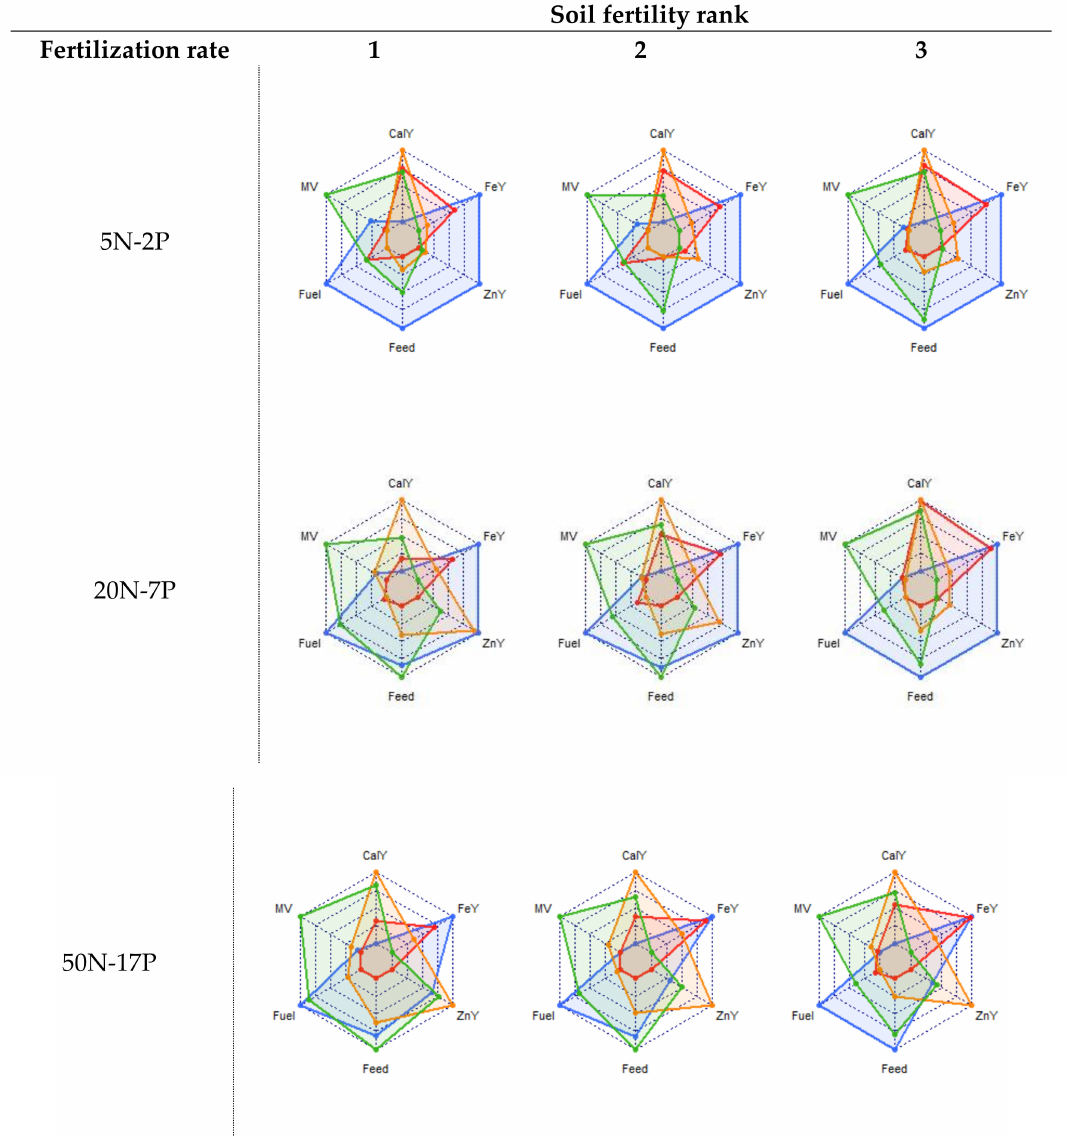
Figure 6. Multi-criteria yield assessments on an area-scaled basis (per hectare) of millet (blue), sorghum (red), maize (yellow) and rice (green); in six different paddocks, defined by two factors: mineral fertilizer application rate (kg ha − 1 of nitrogen and phosphorus) and soil fertility characteristics (1 = upland low fertility, 2 = upland medium fertility, 3 = hydromorphic soil). Caloric yield (CalY); iron yield (FeY); zinc yield (ZnY); metabolizable energy yield (feed), cooking fuel yield (fuel), monetary value